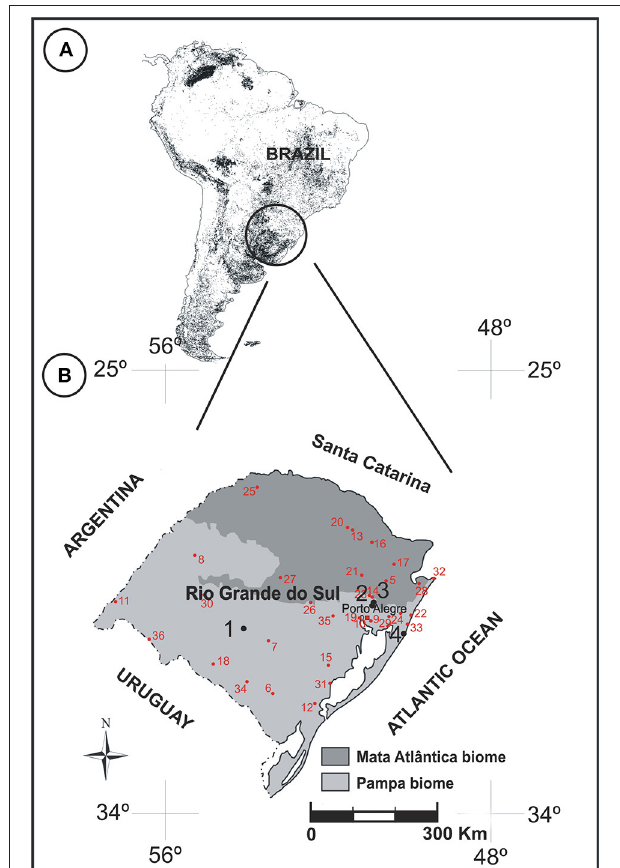
FIGURE 2 | (A) Distribution of grasslands in South America highlighting the southern region of Brazil (adapted from Eva et al., 2002). (B) Map of Rio Grande do Sul showing the sampling sites in RS (black circles): 1. “Cerro do Ouro,” São Gabriel city; 2. Cachoeirinha city; 3. “Sitio Laranjal,” Gravataí city; 4. “Balneário Quintão,” Palmares do Sul city. Red circles indicate regions of collection of herbarium species (see Table 2 for more details of the names of